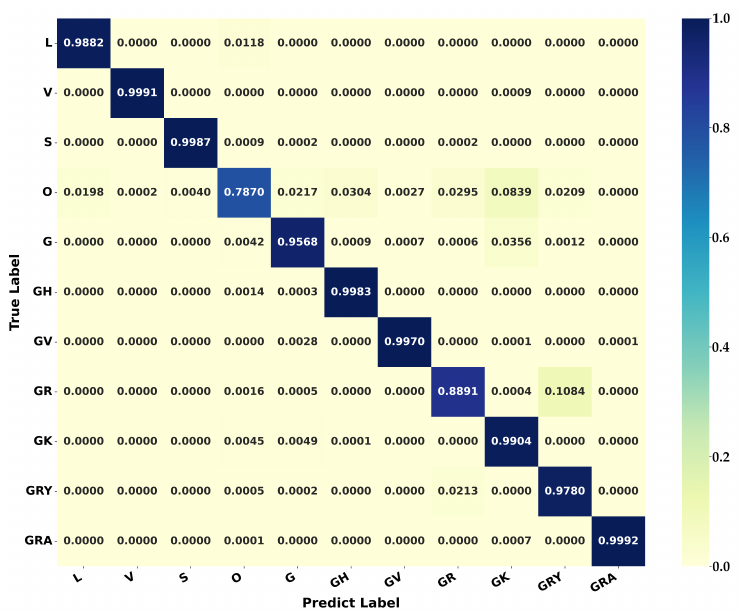
Figure 13. Confusion matrix produced by the ensemble model on the GISAID testing dataset S G using data structure f 2 . The dark color represents a larger